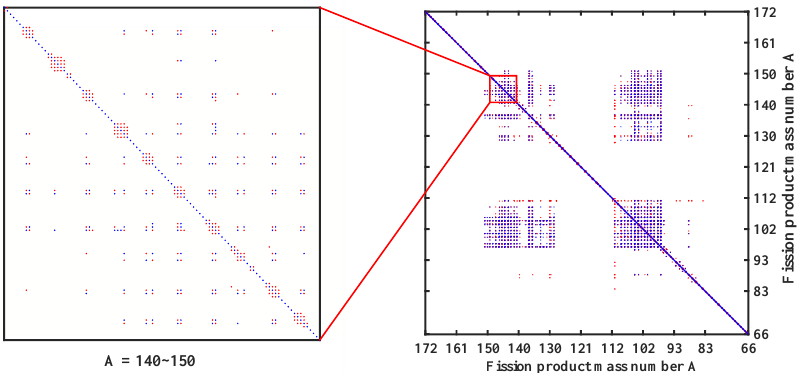
Figure 2. Correlation coefficient matrix of independent fission product yield from 239 Pu (correlation coefficient absolute values >0.01 are shown; blue: negative correlation; red: positive correlation).